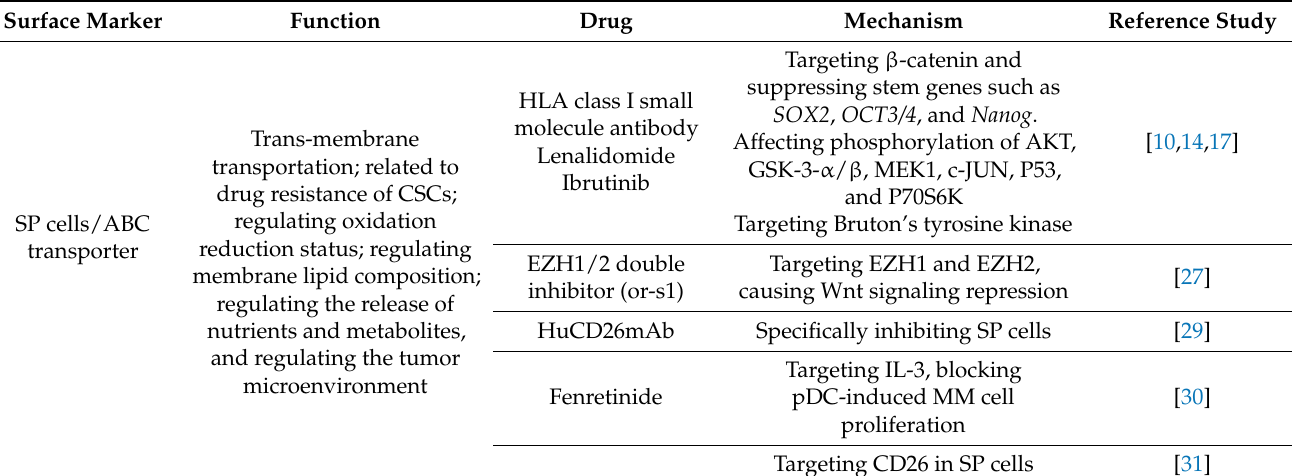
Table 1. Markers of the MM stem cell-like population and inhibitors of